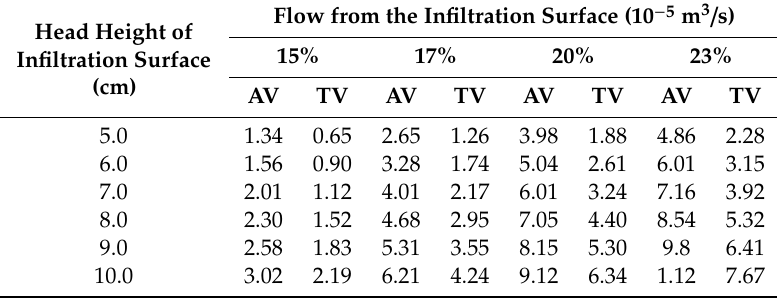
Table 6. Comparison table of three-dimensional finite element and numerical theoretical calculation results of infiltration flow at di ff erent head